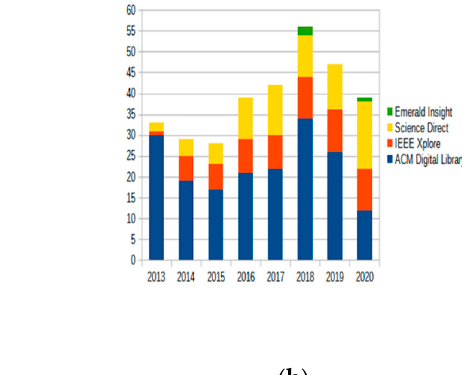
Table 3. Popularity of the topic in the digital library.